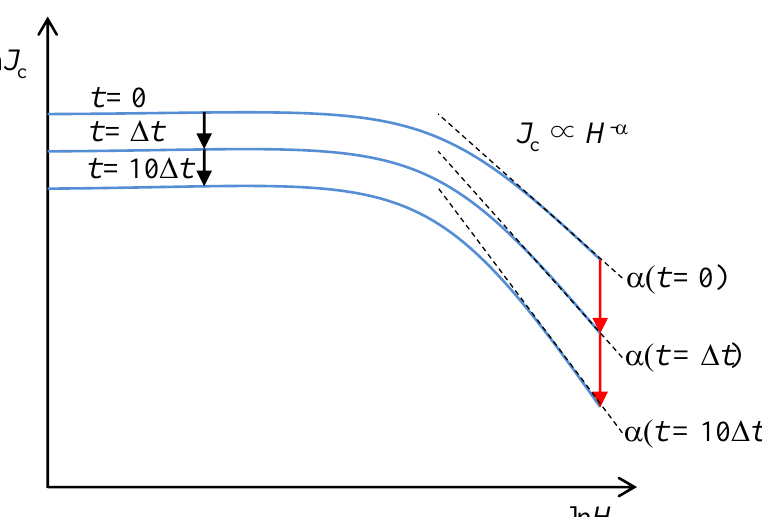
Figure 6. Schematic magnetic field dependence of J c in a double logarithmic plot at different times after preparing the critical state at t = 0. When the normalized magnetic relaxation rate increases appreciably with the field, measured J c values at high fields after some time delay ( t , 10 t , . . . ) become smaller, resulting in stronger apparent magnetic field dependence of J c , namely a larger α .